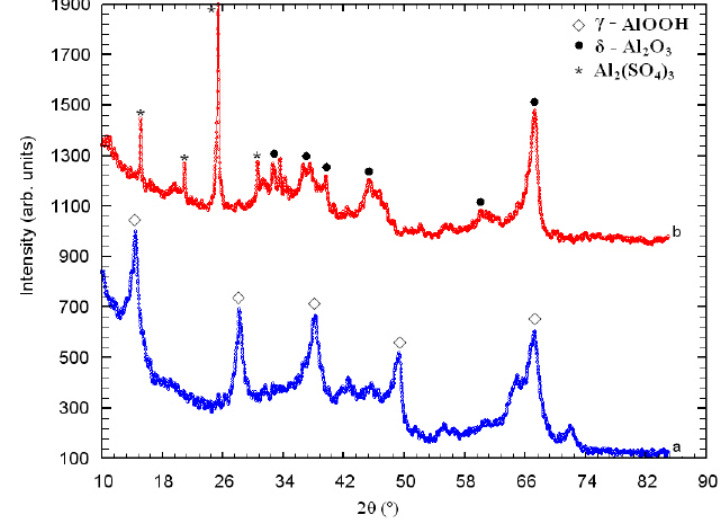
Figure 6. X-ray diffractions patterns of 0.1 wt.% Pt/Al